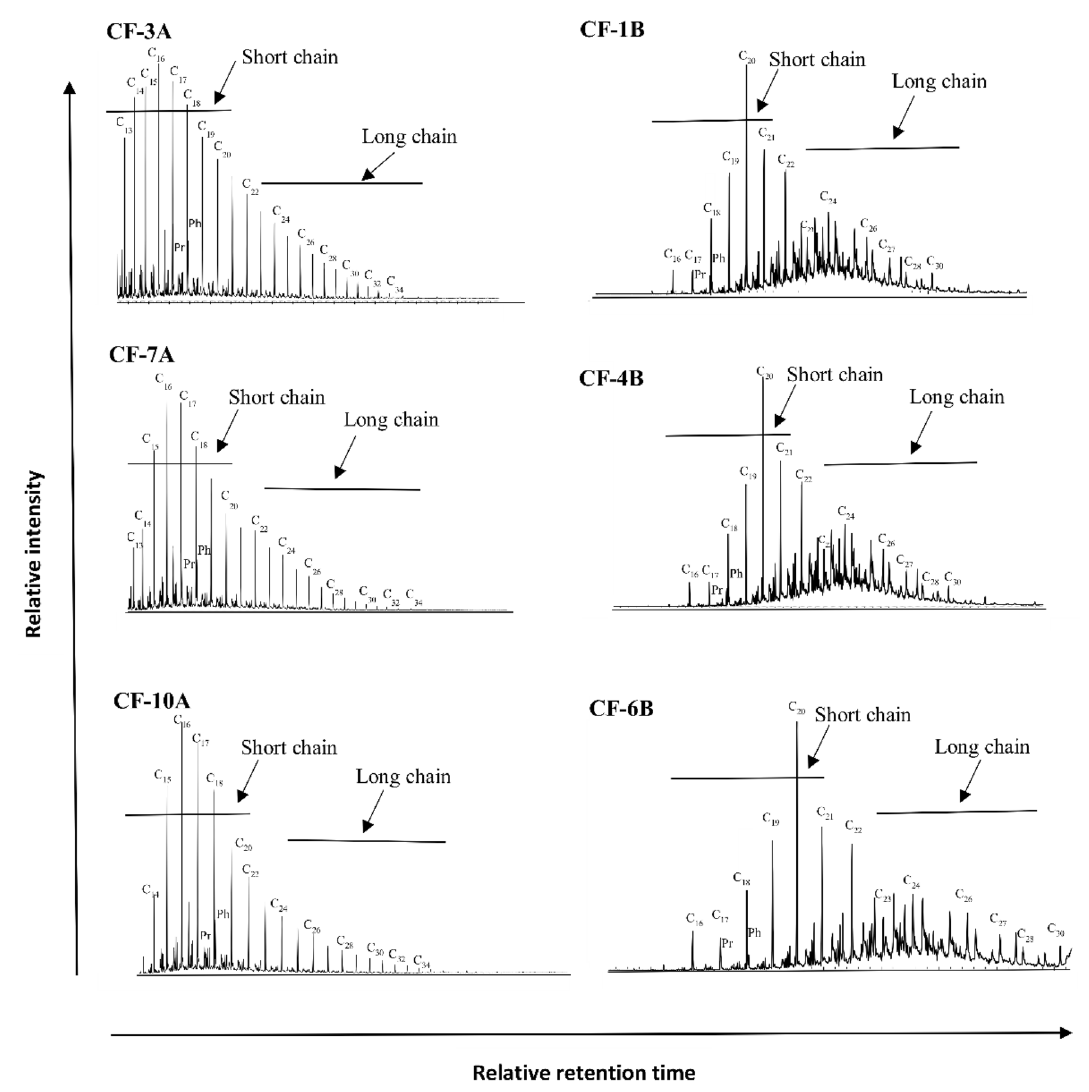
Fig. 7 m/z 57 chromatograms of Mela-05 drill cuttings (left) and outcrop samples (right) showing distribution of n-alkanes and isoprenoids